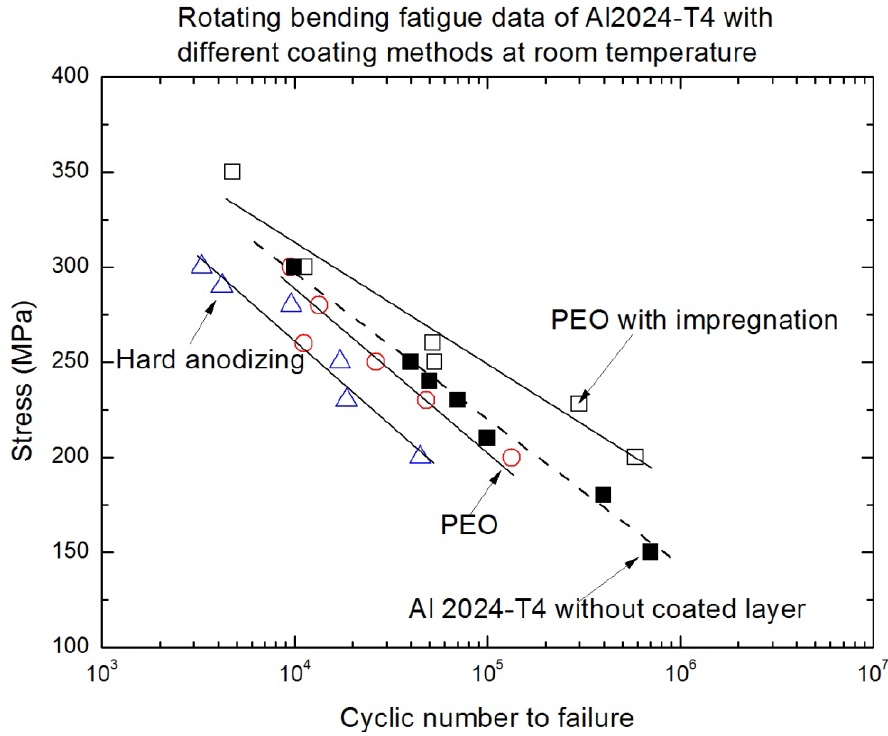
Figure 3. S-N curves of 2024-T4 Al alloy with the oxide coating and